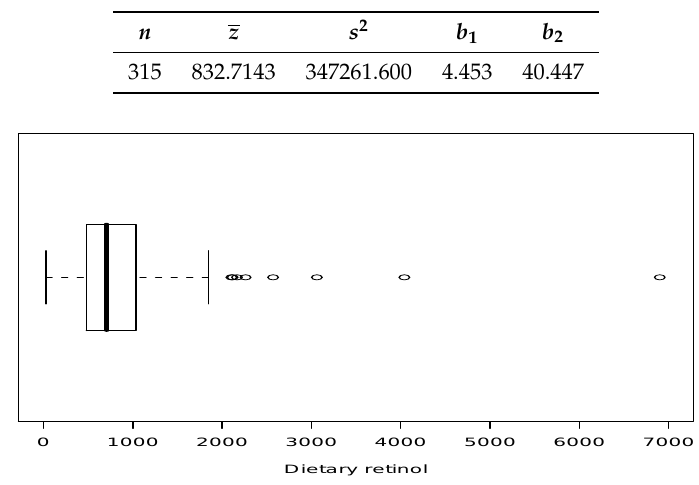
Figure 5. Boxplot for retinol dataset.